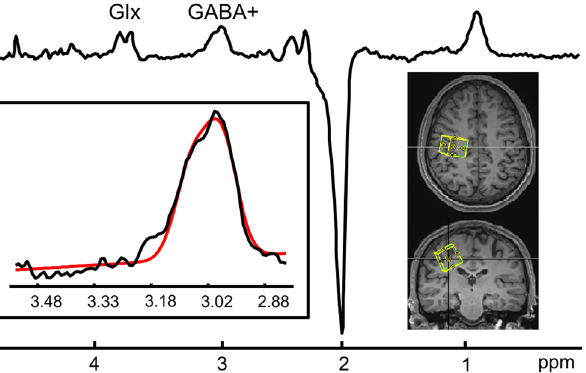
Figure 3. The voxel location covering the contralateral sensorimotor region and the edited spectra from a representative subject. The insert shows the fitted peak of GABA + (red line) using two Gaussian models with 7 variables (2 height, width, splitting, baseline offset, and baseline gradient) in the spectral range of 2.79–3.55